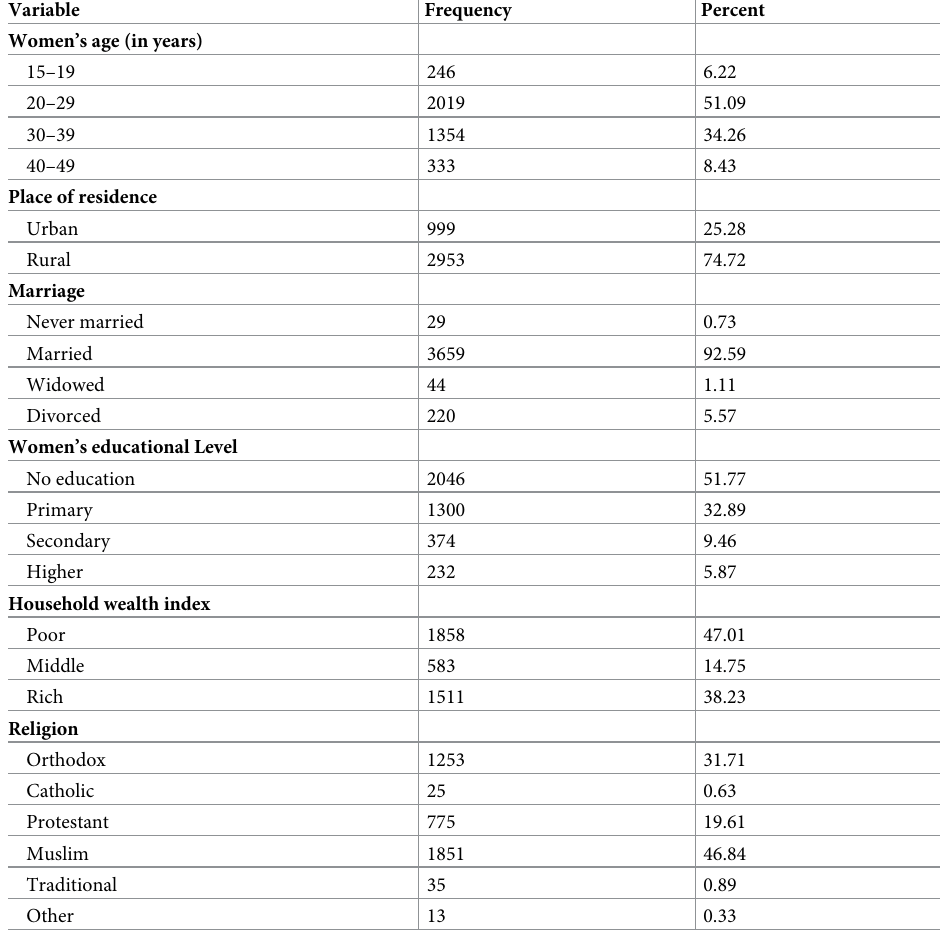
Table 1. Socio-demographic characteristics of women in Ethiopia (n =